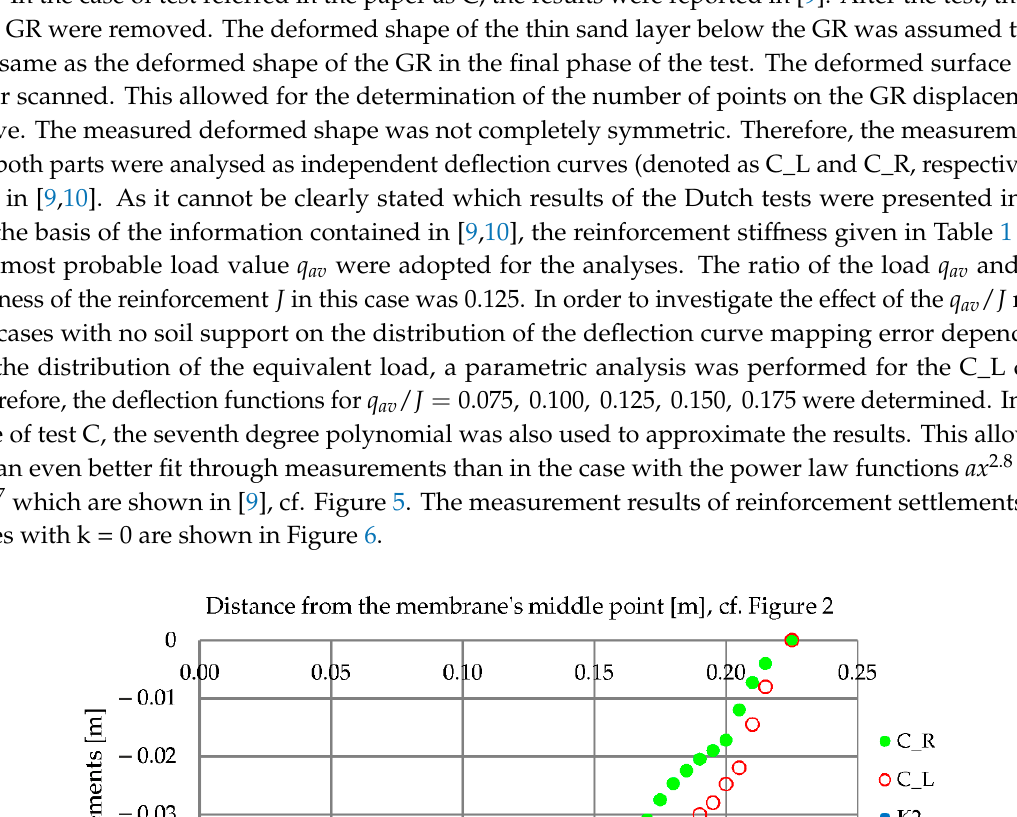
Figure 6. Results of settlement measurements for tests K2, T3 and C [9,10].